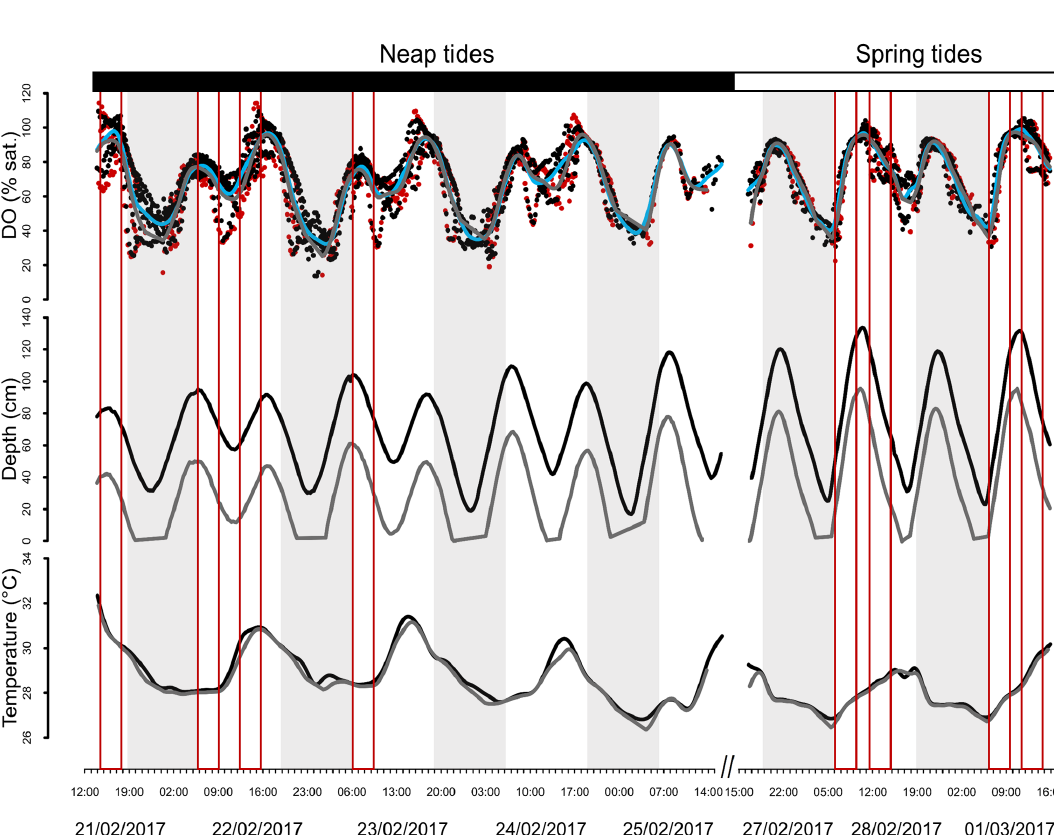
Figure 2. Cubic spline smoothers for dissolved oxygen (DO), depth and temperature. Data are from 21 to 25 February 2017 and from 27 February to 1 March 2017. For DO, edge sites are represented by the blue smoother and black points and in-forest sites by the grey smoother and red points. For the other factors, edge sites are represented by the black smoothers and in-forest sites by the grey smoothers. Shaded areas represent sunset to sunrise. Each red box represents an underwater camera